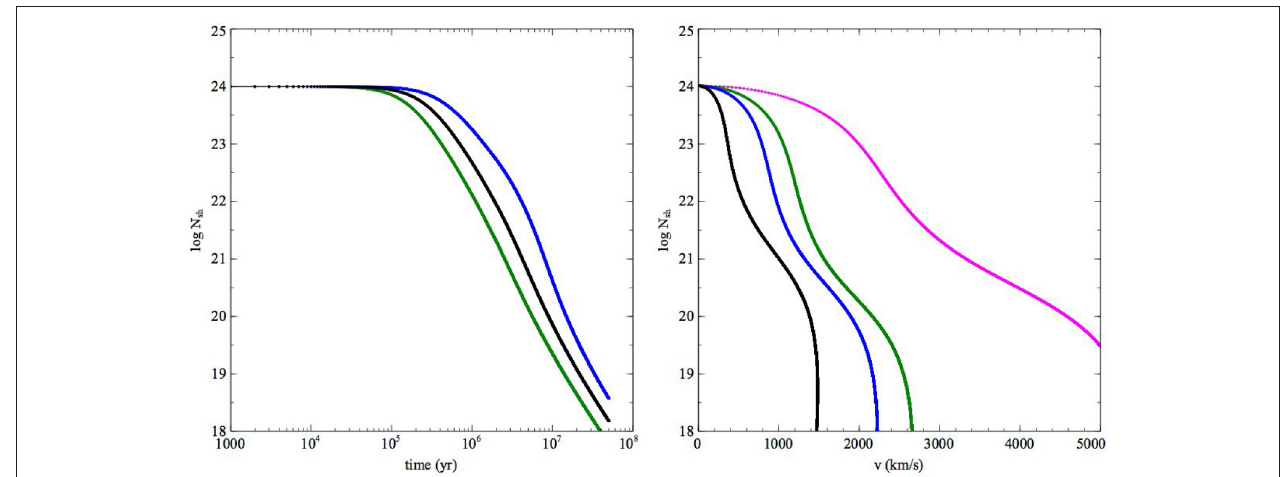
FIGURE 2 | Left: shell column density vs. time for variations in luminosity ( N sh ,0 = 10 24 cm − 2 , f dg = 1 / 150): L = 3 × 10 46 erg/s (blue), L = 5 × 10 46 erg/s (black), L = 1 × 10 47 erg/s (green). Right: shell column density vs. velocity for variations in the dust-to-gas ratio ( L = 2 × 10 46 erg/s, N sh ,0 = 10 24 cm − 2 ): f dg = 1 / 150 (black), f dg = 1 / 50 (blue), f dg = 1 / 30 (green). High-luminosity case: L = 10 47 erg/s, f dg = 1 / 50